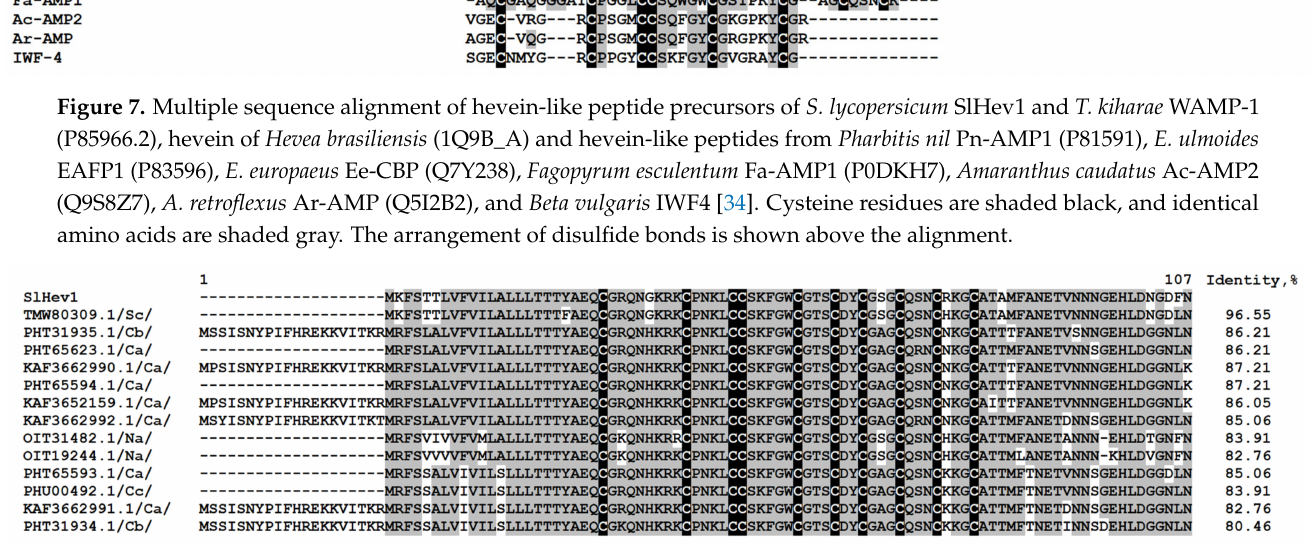
Figure 8. Multiple sequence alignment of S. lycopersicum hevein-like peptide precursor SlHev1 and homologous sequences of Solanum chilense (Sc), Capsicum baccatum (Cb), C. annuum (Ca), Nicotiana attenuata (Na), and C. chinense (Cc). Cysteine residues are shaded black, and identical amino acids are shaded gray. Sequence identity values are shown to the right of the